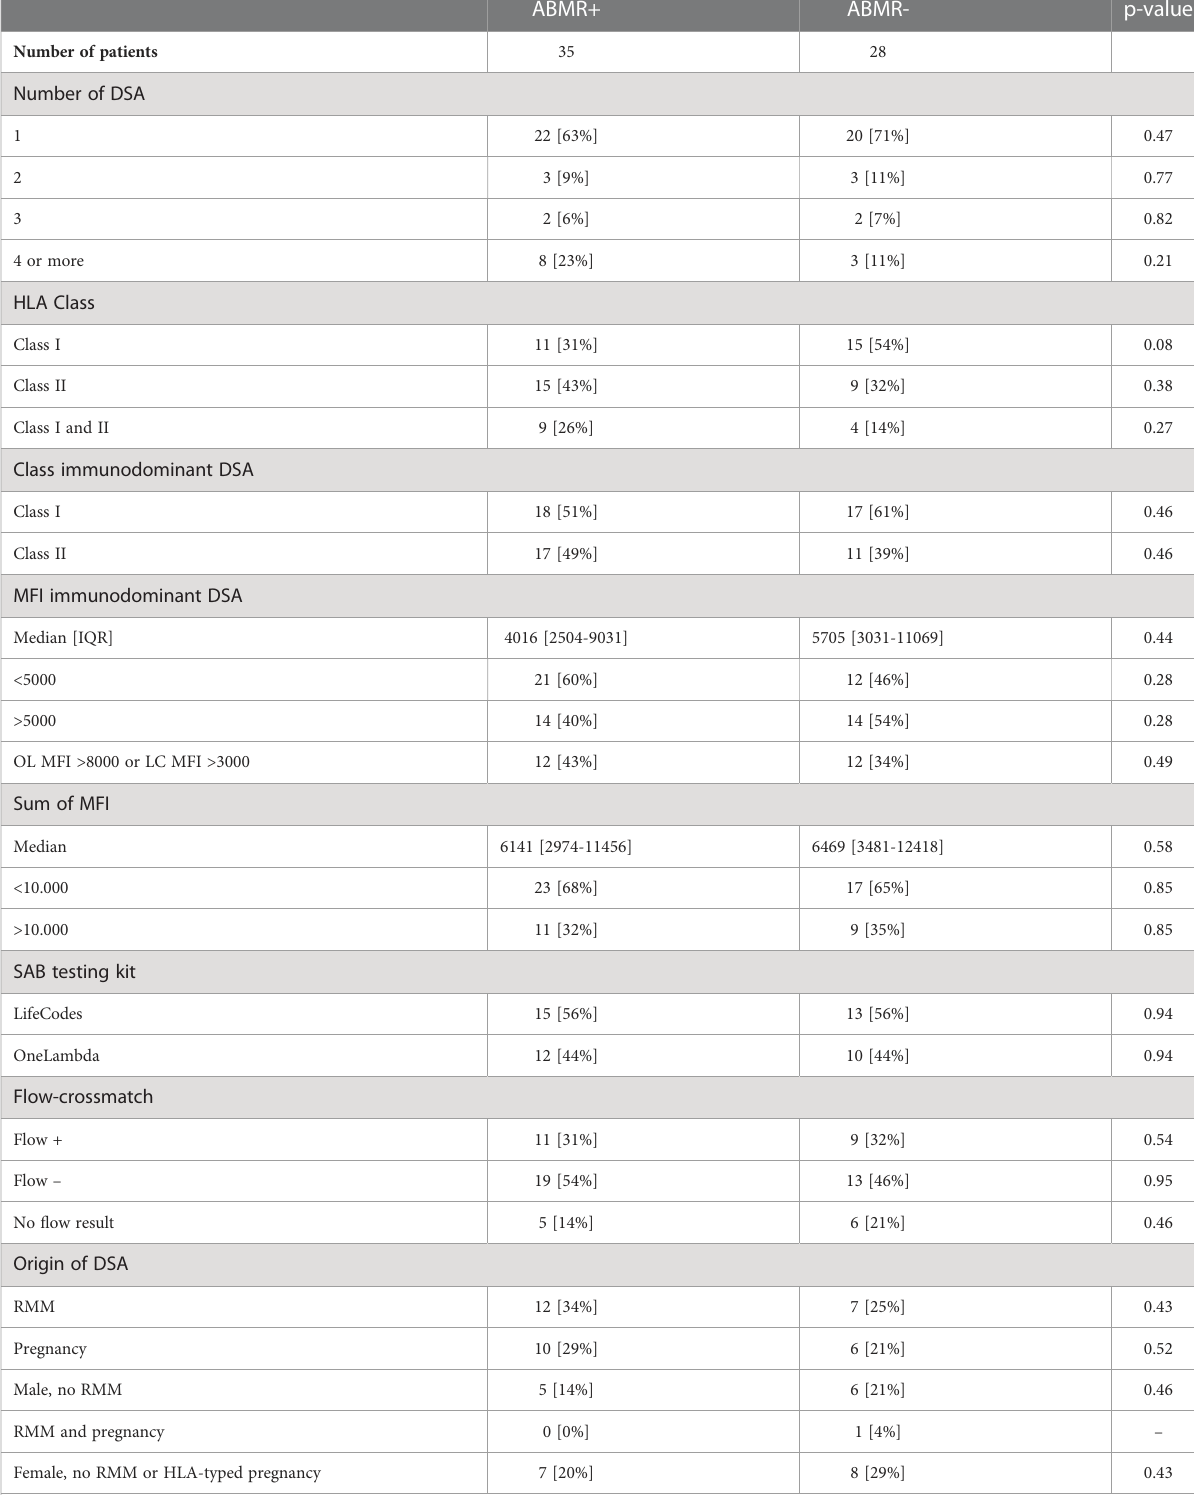
TABLE 3 Immunological characteristics of DSA+